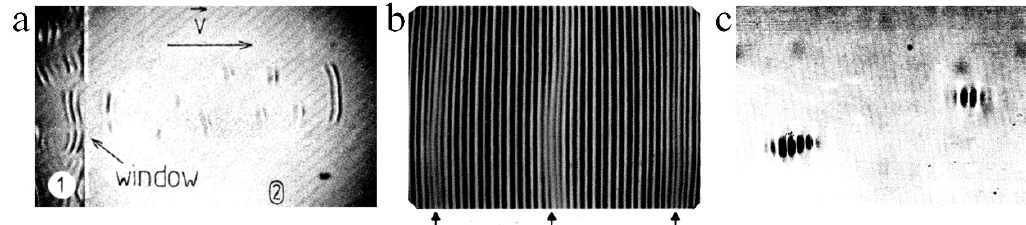
Figure 4. ( a ) Portions of convective rolls “emitted” from region 1 to region 2. Reprinted with permission from Ref. [28]. Copyright 1979 American Physical Society. ( b ) Micrograph of a quasiperiodic convective structure. The solitons (indicated by arrows) are regions of compression of the rolls. Reprinted with permission from Ref. [29]. Copyright 1985 American Physical Society. ( c ) Micrograph of localized domains of travelling convective rolls. Reprinted with permission from Ref. [31].